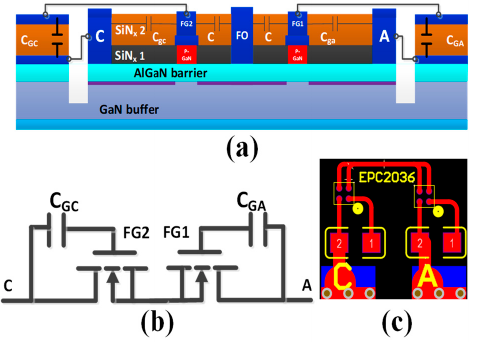
Figure 1. ( a ) The schematic structure and ( b ) equivalent circuit of the proposed AlGaN/GaN B-ESD- PD. ( c ) The equivalent structure configured using the chip capacitor and the commercially p-GaN HEMT (EPC2036) from the EPC Corporation [20].